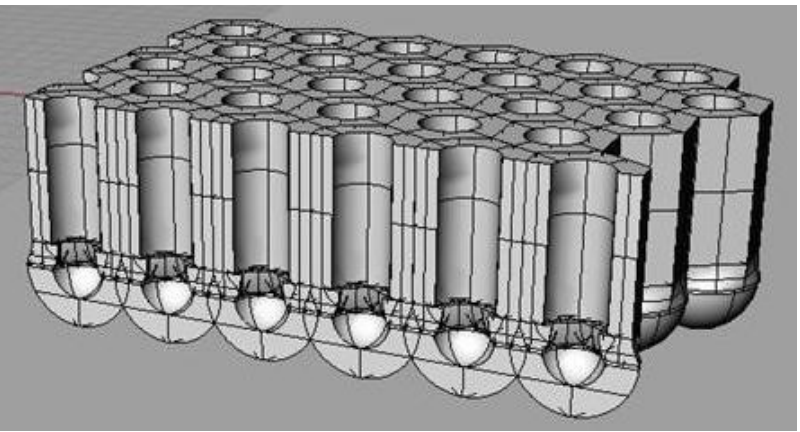
Figure 1. Schematic representation of the alumina porous structure formed by aluminum anodizing.